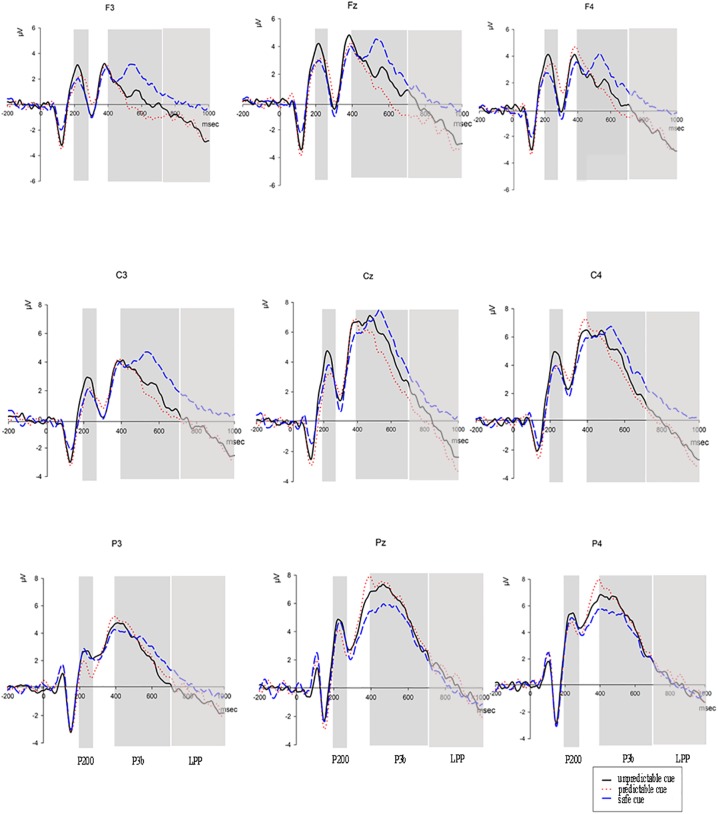
Grand-averaged ERP waveforms at nine electrodes evoked by cue pictures.The black line indicates ERP waveforms evoked by UC, the long-dashed line illustrates ERP waveforms elicited by SC, the short-dashed line shows ERP waveforms in the PC condition. The x-axis indicates the time scale, which is marked in intervals of 200 ms. The time scale started 200 ms pre-stimulus onset. The y-axis indicates the amplitudes, which are marked in intervals of 2μv.